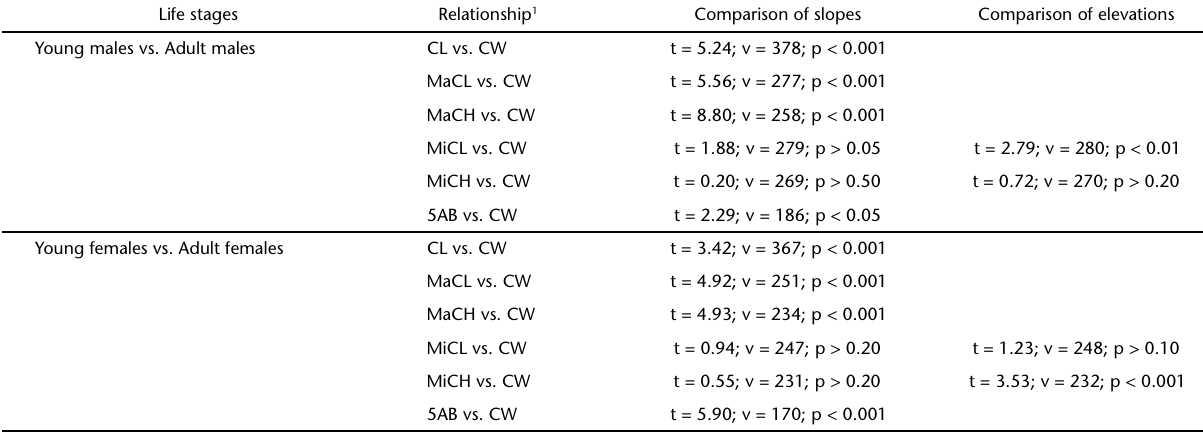
Table II. Trichodactylus fluviatilis . Student’s t comparisons of linear regression parameters between juvenile and adult life stages. v, degrees of freedom. Life stages Relationship 1 Comparison of slopes Comparison of elevations